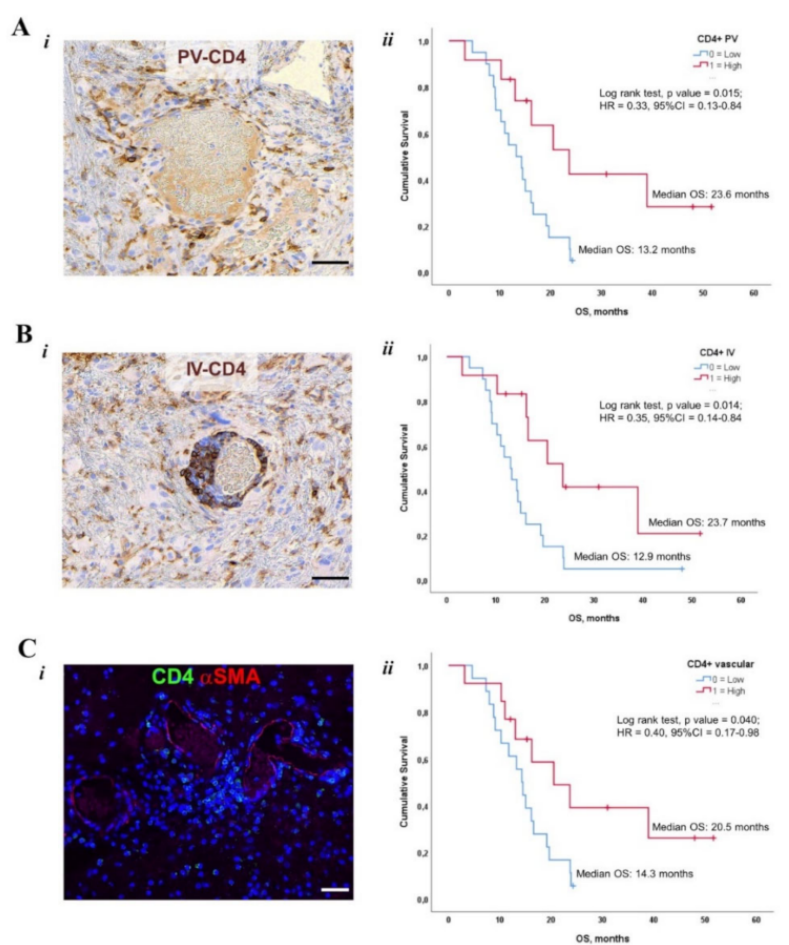
Figure 5. Impact of TIME features on survival outcome. ( A i – B i ): Representative images of im- munoperoxidase stained sections from glioblastoma samples documenting the perivascular (PV, ( A i )) and intravascular (IV, ( B i )) localization of CD4+ (brownish) lymphocytes. ( C i ): double immunofluo- rescence staining on a section of glioblastoma to simultaneously detect CD4 (green) and a-Smooth Muscle Actin (a-SMA, red). CD4+ lymphocytes are aggregated in a PV cluster or in contact with a-SMA cells. Scale Bars: 50 µ m. Kaplan–Meier survival curves documenting Overall Survival (OS) according to the incidence ( n /mm 2 ) of PV ( A ii ), IV ( B ii ) and overall vascular (PV+IV, ( C ii )) CD4+ TILs,